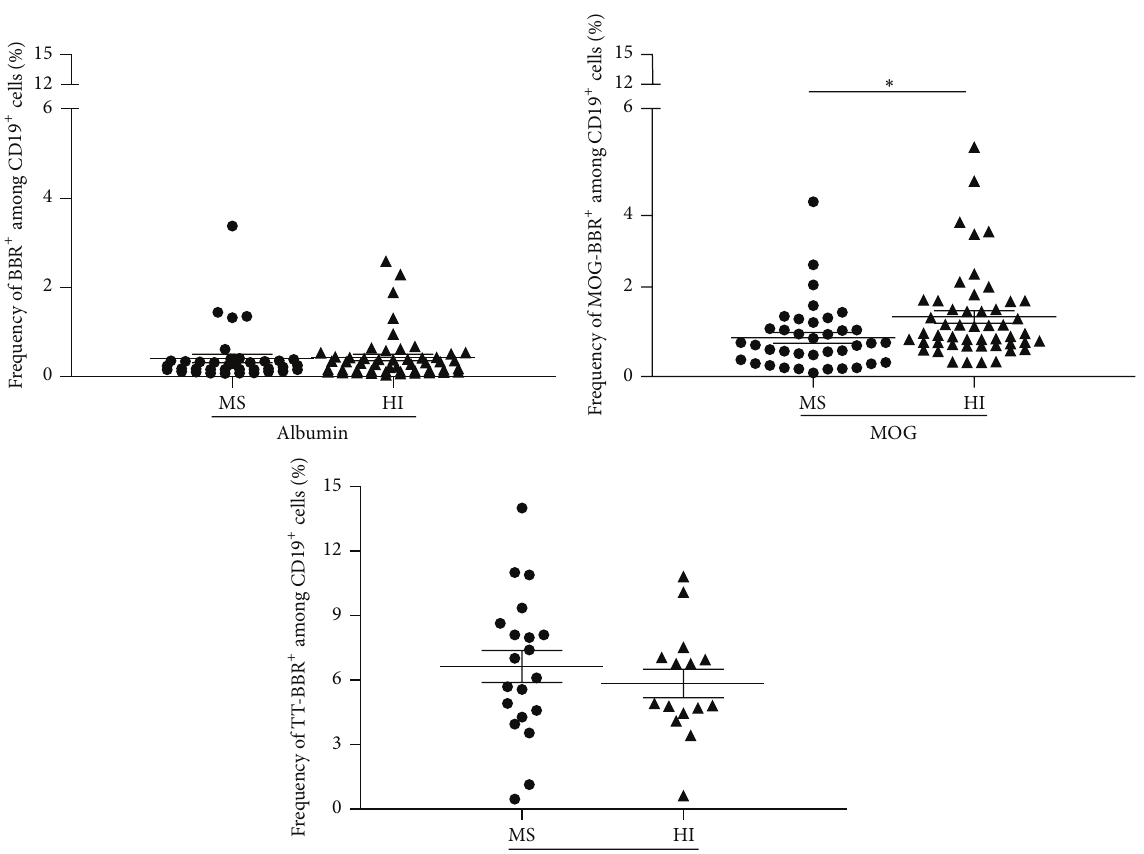
Figure 1: Quantification of MOG-specific B cell frequencies in MS patients and HI. Purified B cells, stained with CD19 antibody, were incubated with human albumin, rMOG, or tetanus toxin (TT) coated beads. After exclusion of dead cells (DAPI + ), the frequency of B cells which recognized albumin or rMOG was obtained in MS patients ( 𝑛 = 38 ) and HI ( 𝑛 = 50 ) ∗ 𝑃 = 0.0188 , unpaired 𝑡 -test . The frequency of B cells bound to TT coated beads was also assessed in MS patients ( 𝑛 = 20 ) and in HI ( 𝑛 = 15 ) (ns, 𝑃 > 0.05 , Mann-Whitney test ).